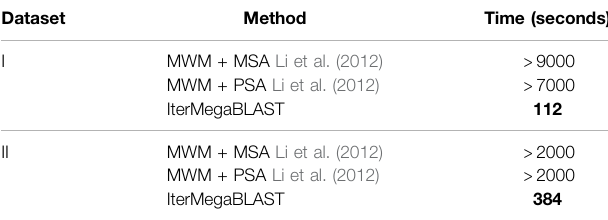
Bold values indicate the best